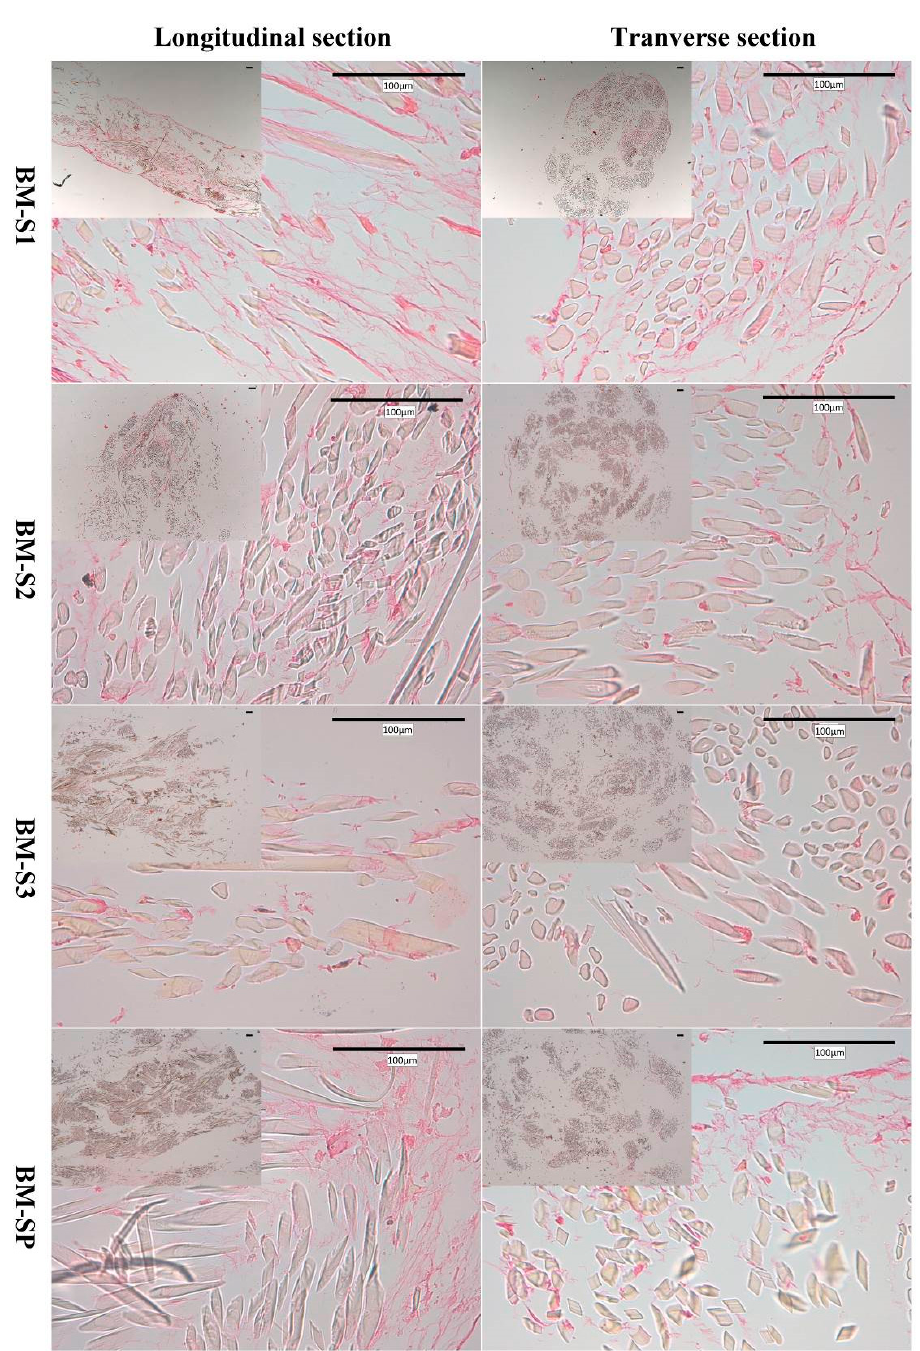
Figure 5. Observation of BM-MSCs on S1, S2, S3 and SP scaffolds from Red Sirius (RS) staining.